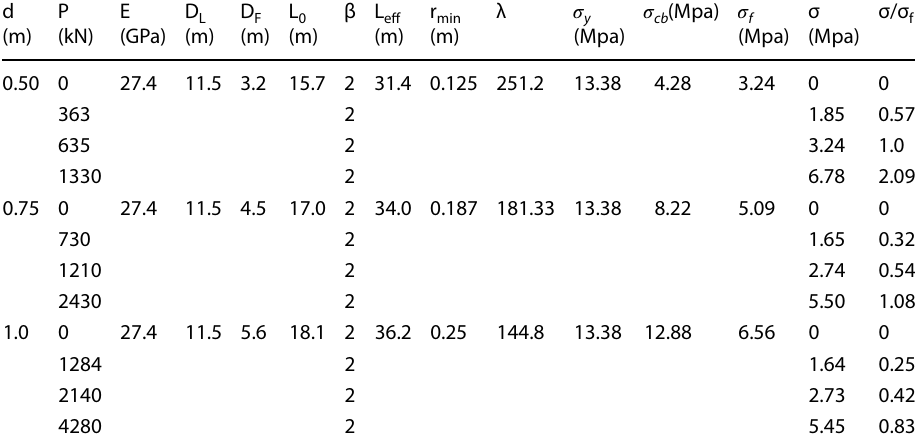
Table 9 Checking against buckling failure mechanism of various diameter pile of M-30 grade in RCD soil under scaled IMV motion